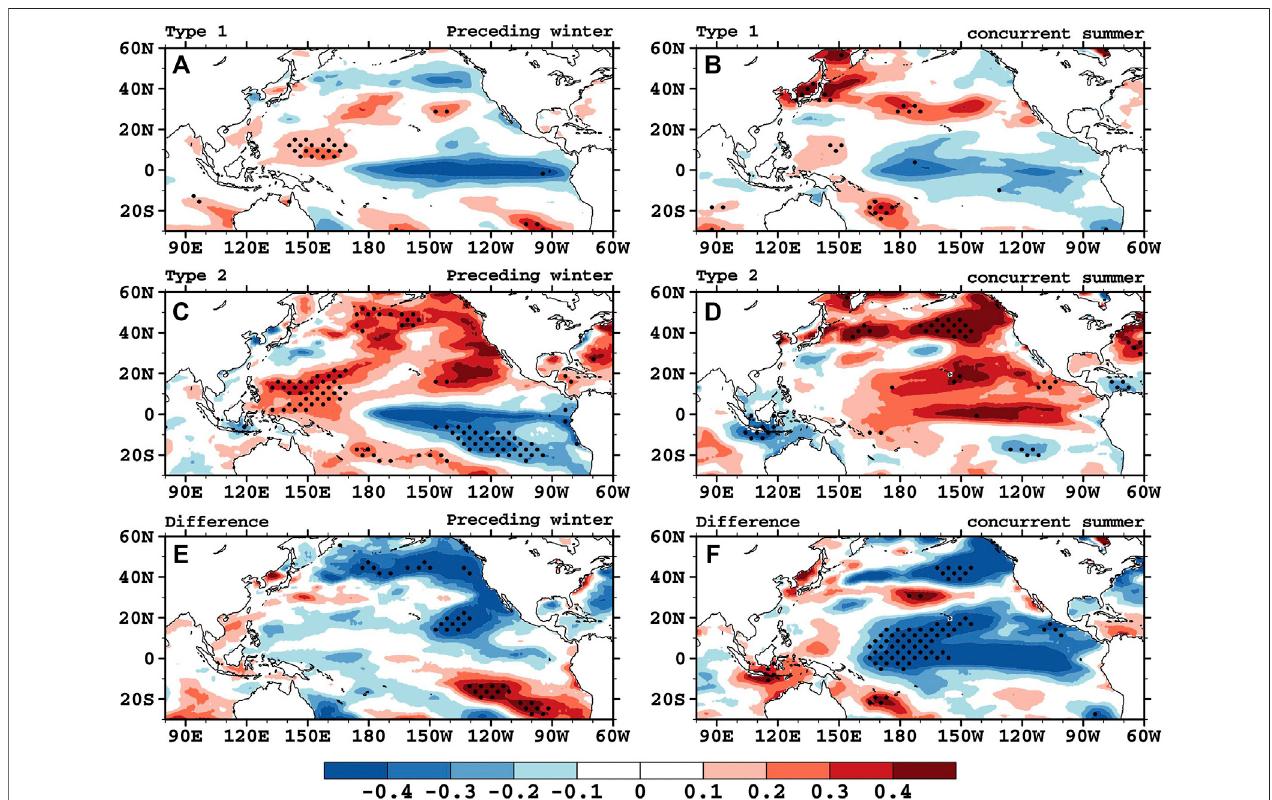
FIGURE 4 | Composited preceding winter SST anomalies for type 1 (A) , type 2 (C) years and different fi elds of preceding winter SST anomalies of type 1 and type 2years (E) .CompositedconcurrentsummerSSTanomaliesfor type1 (B) , type2 (D) years, and different fi eldsofconcurrentsummerSSTanomalies oftype 1andtype 2 years (F) . Dotted areas indicate a 90% signi fi cance